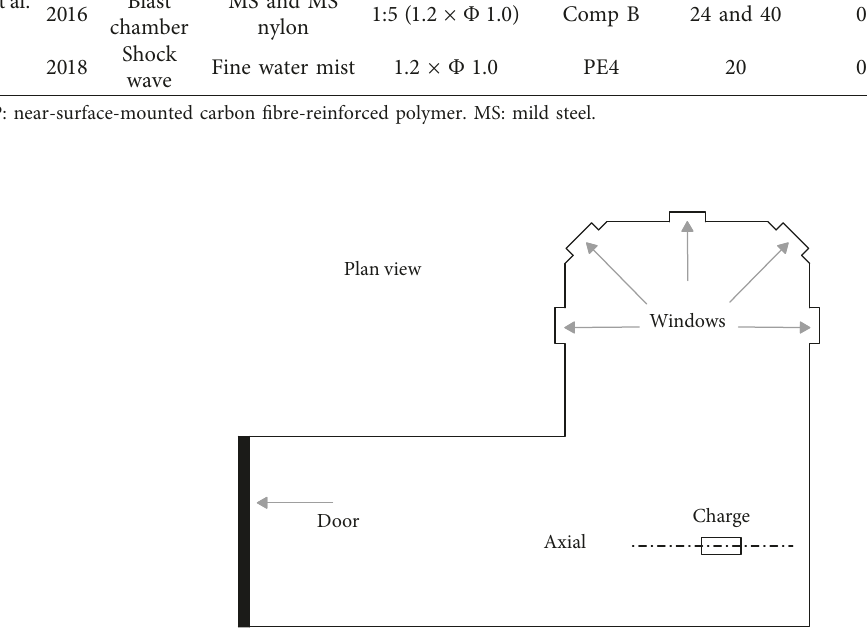
Figure 7: Rectangular blast chamber